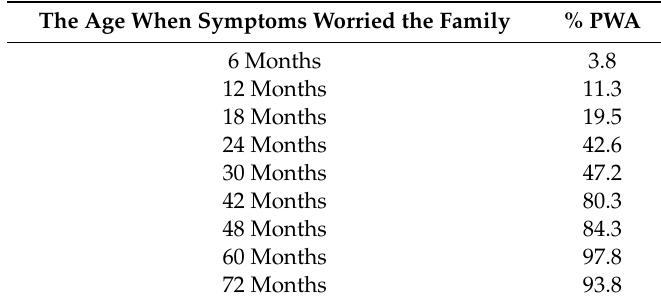
Table 5. Age of PWA when the first ASD symptoms worried the family.